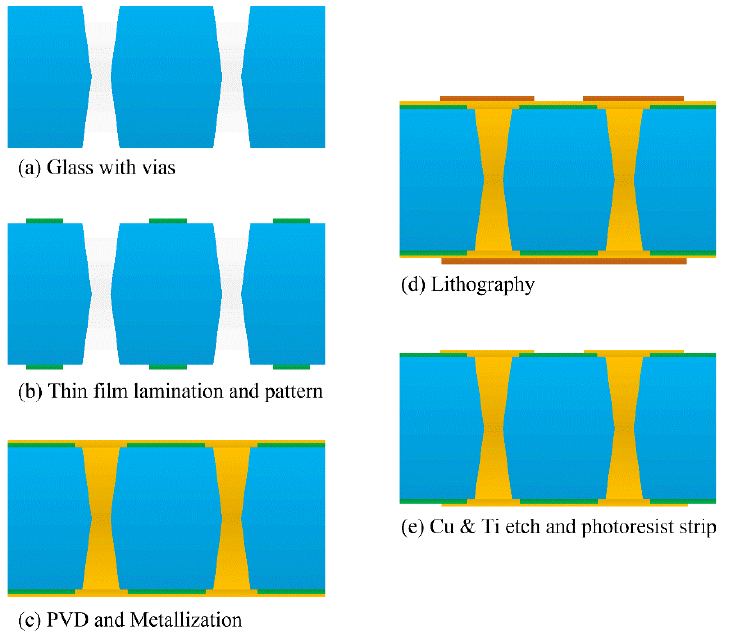
Figure 18. The manufacturing process flow of TGV interconnection structure by laminating a thin polymer film for a buffer layer.